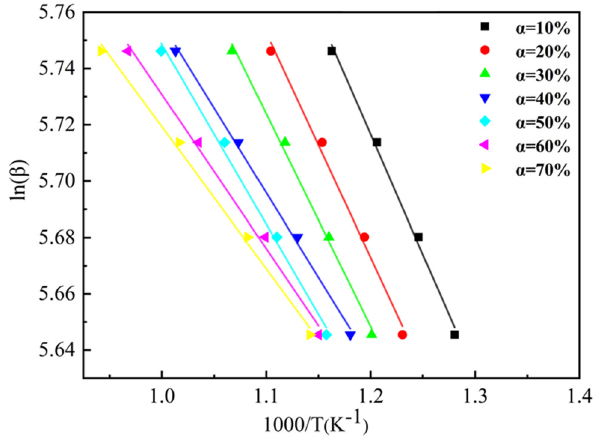
Figure 10: FWO method plots of sample K3 in di ff erent conversion degrees.